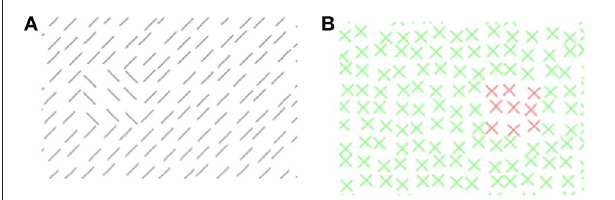
FIGURE 5 | Experiment 2: (A) stimulus texture with orientation-defined target. (B) Mask texture with color-defined patch. (A,B) The number and luminance of elements has been reduced for better visualization of the texture